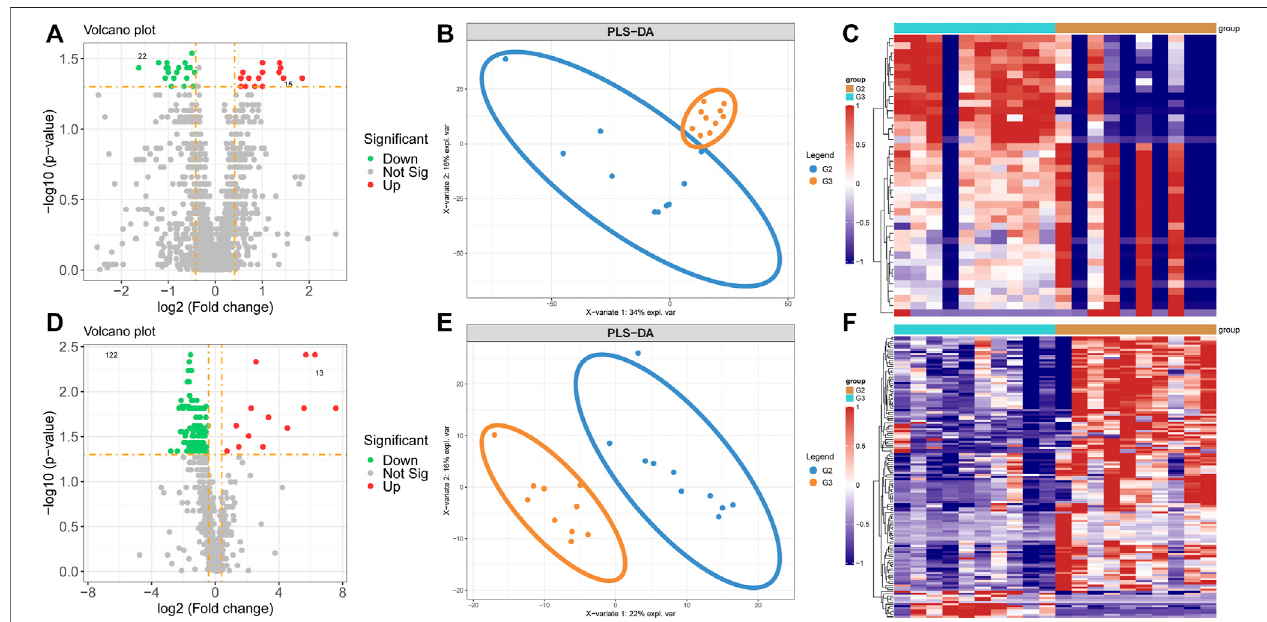
FIGURE4 | Metabolomics and proteomics analyses ofvalvular AF and non-valvular AF samples. (A – C) The volcanoplot (A) , PLSDA analysis (B) and heatmap (C) showedthedifferentlyexpressedproteinsinnon-valvularAFcomparedtovalvularAFsamples. (D – F) Thevolcanoplot (D) ,PLSDAanalysis (E) andheatmap (F) showed the differently expressed metabolites in non-valvular AF compared to valvular AF